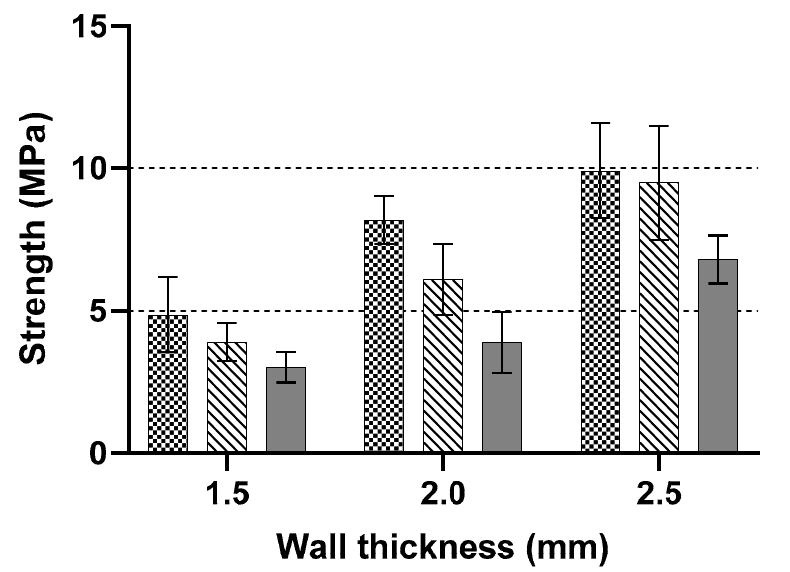
Figure 8. Comparison between constant wall thicknesses with variable cell sizes.